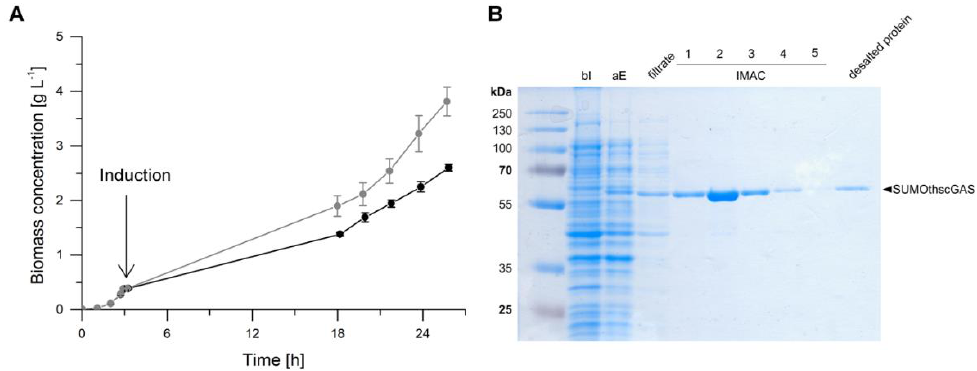
Figure 4. ( A ) Cultivations of induced (black dots) and non-induced (grey dots) E. coli BL21 (DE3) pLysS pET-28 a ( + ) SUMOthscGAS in 2xYT medium and shake flasks. Cells were incubated at 37 ◦ C until an OD 600 of 1, cooled on ice for 15 min before induction, and subsequently incubated at 15 ◦ C for protein synthesis. A conversion factor of 0.312 g L − 1 represented by 1 OD 600 unit was used for calculation of biomass concentration. Error bars relate to biological duplicates. ( B ) SDS-PAGE gel image of synthesis and purification of SUMOthscGAS; bI: before induction; aE: after expression; filtrate: filtered cell